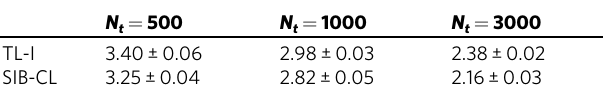
Table 1 PhC-DOS